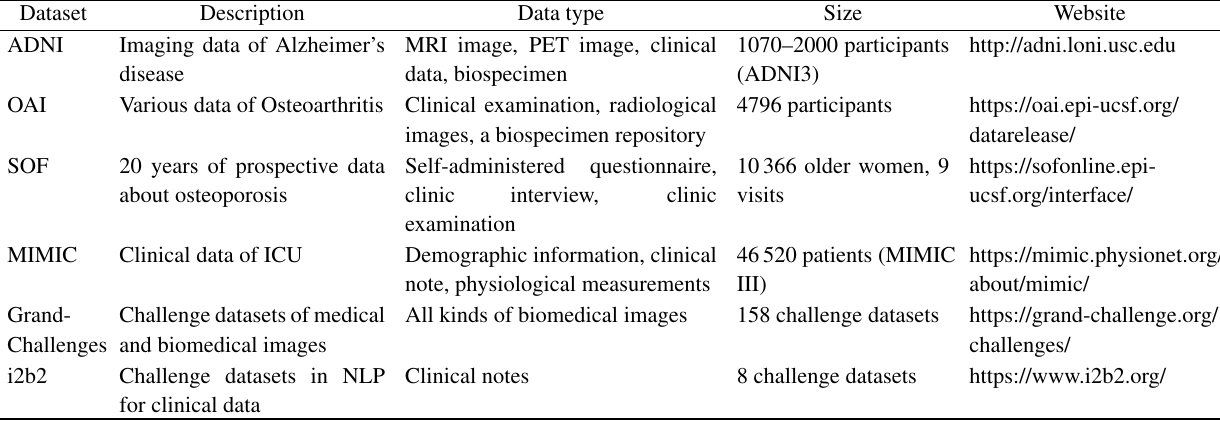
Table 1 Public clinical dataset